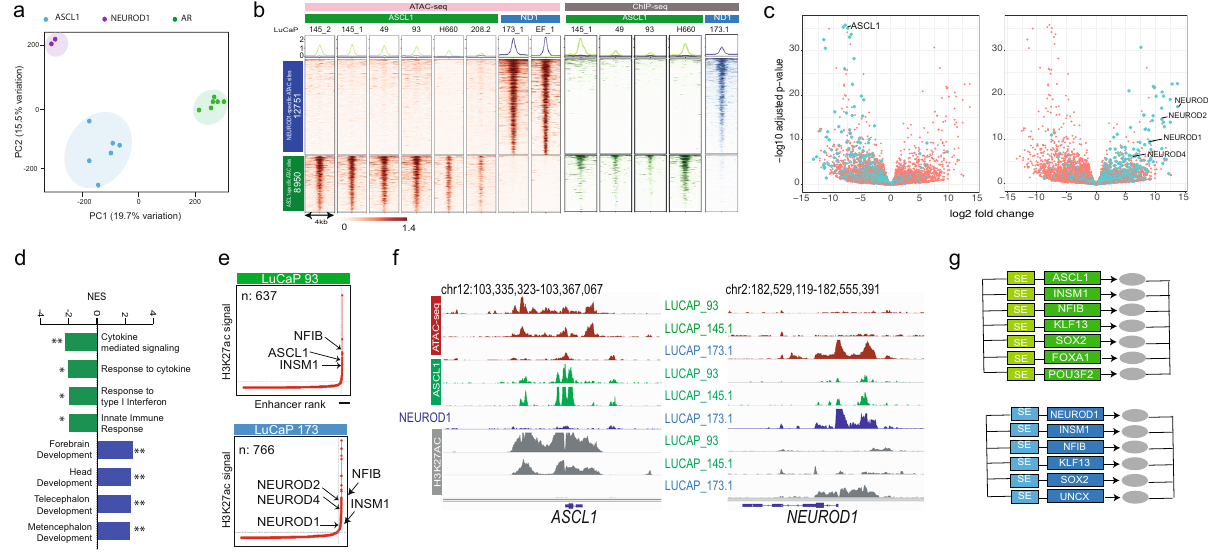
Fig. 2 NEPC shows tumor subtypes based on the differential expression of the transcription factors ASCL1 and NEUROD1. a Principal component analysis of ATAC-seq data from NEPC and ADPC PDXs. Samples are color coded by the dominant TF expressed in that sample. b The left side of the heatmap (red) displays the differential ATAC-seq regions identi fi ed between NEPC subtypes. There are 12,751 NEUROD1-speci fi c regions (top) and 8950 ASCL1-speci fi c (bottom) ATAC sites. The right side of the heatmap shows the ChIP-seq data at the same sites for ASCL1 (green) and NEUROD1 (blue) for the indicated samples. c Association between differential ATAC-accessible sites and differential gene expression. Each volcano plot depicts RNA-seq log2- fold change ( x -axis) and p -value adjusted for multiple hypothesis testing calculated by DESeq2 using a Wald ’ s test ( y -axis). Each dot represents one gene: green indicates a differential ATAC peak is within 50 kB of the gene and orange indicates there is no such peak. Left: ASCL1-speci fi c accessible regions and genes upregulated in ASCL1 subtype; (right) NEUROD1-speci fi c accessible regions and genes upregulated in NEUROD1 subtype. d GSEA pathway analysis of genes enriched in the ASCL1 subtype (green) and the NEUROD1 subtype (blue) (** q -value < 0.001, * q -value < 0.05). e Signal distribution of H3K27ac marked enhancers from representative cases of the ASCL1 subtype (top) and NEUROD1 subtype (bottom). The bars in the lower right of each plot identify the subset of enhancers known as super-enhancers de fi ned by the ROSE algorithm; 693 were identi fi ed in LuCaP 93 (ASCL1) and 766 in LuCaP 173.1 (NEUROD1). Super-enhancers nearby selected genes are indicated by the arrows. f Representative IGV tracks at the ASCL1 and NEUROD1 gene loci. ATAC-seq tracks are in red, ASCL1 ChIP-seq in green, NEUROD1 ChIP-seq in blue, and H3K27ac in gray. The loci are marked by subtype-speci fi c super- enhancers with preferential binding of their respective TF. g Circuits of lineage transcription factors speci fi c for the ASCL1 subtype (green) and NEUROD1 subtype (blue). Source data are provided as a Source Data fi